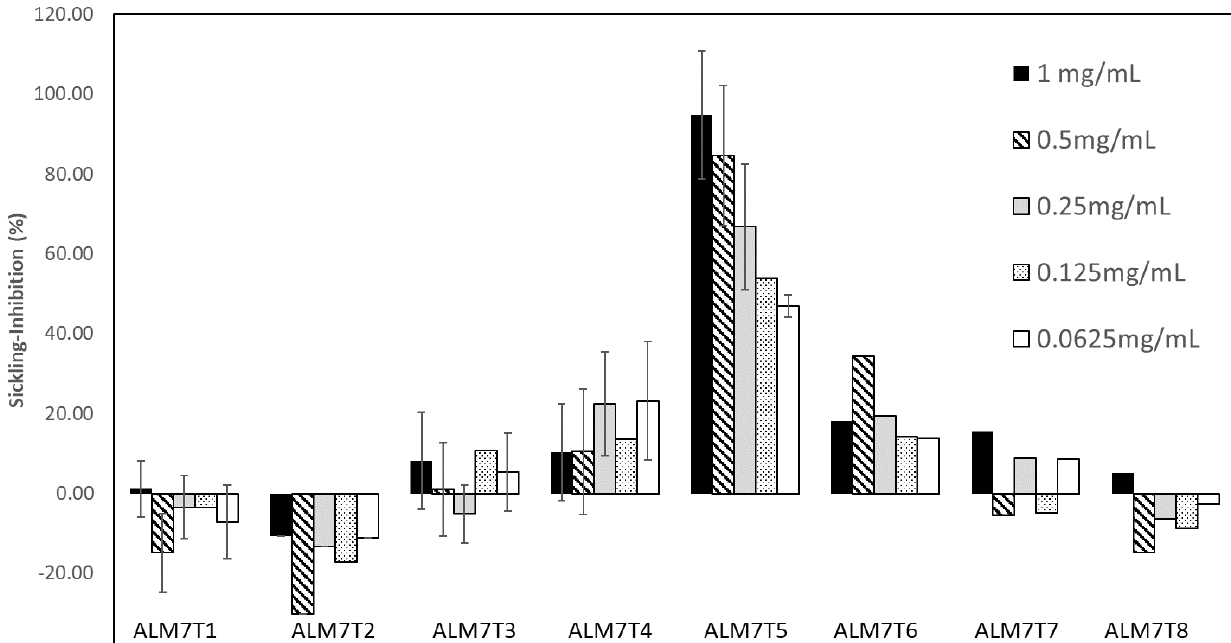
Figure 3. The effect of Alchornea methanol extract fractions of ALM7, designated ALM7T1-8 (see Figure S1) on ex vivo erythrocyte sickling in Na 2 S 2 O 5 -induced hypoxia. Treatments with all concen- trations of ALM7T5 showed significant increases ( p < 0.001) in sickling inhibition over zero. The ability of quercitrin to reverse sickling in erythrocytes in Na 2 S 2 O 5 -induced hypoxia after a 4 h incubation period was tested. The highest concentration tested, 0.80 mg/mL, could reverse sickling (41.8% ± 4.8%) and activity was still detected (18.1% ± 1.2%) at 0.05 mg/mL (Figure 4).